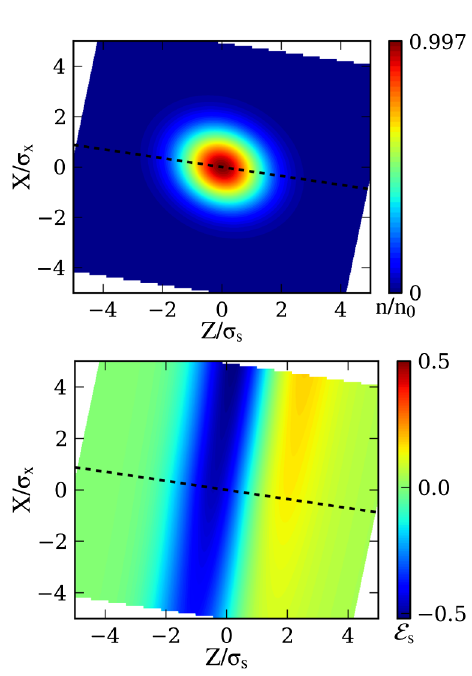
FIG. 15. The beam density n=n CSR field (in MV = m ) in the Cartesian coordinates for a bending angle of (cid:7) ¼ 0 : 175 rad and the same parameters in Fig. 14. n the peak beam density before it enters the magnetic field region.